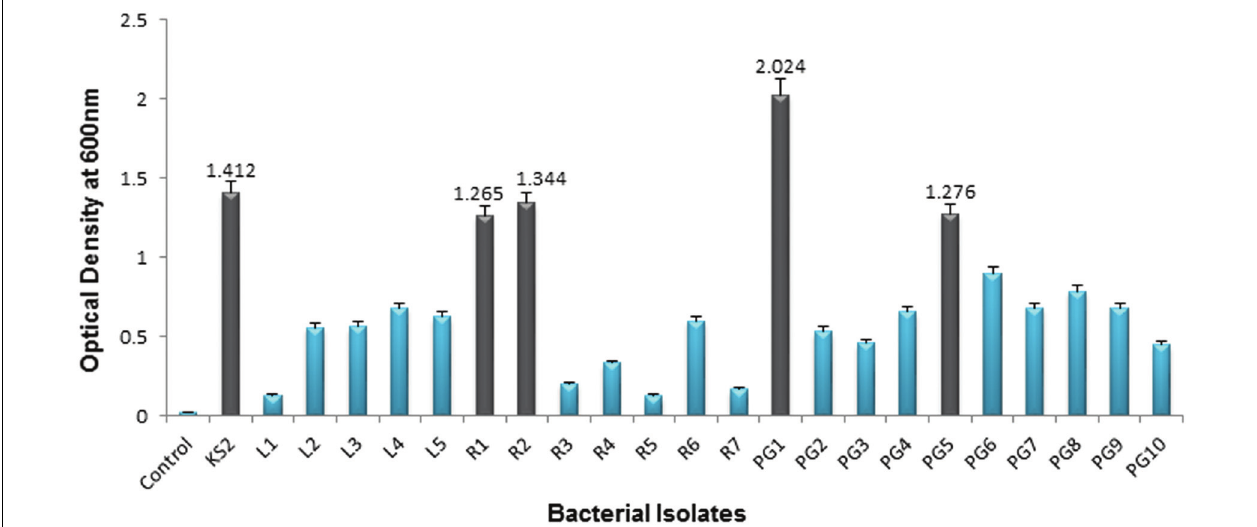
FIGURE 3 | Growth (OD 600 ) of 23 hydrocarbon contaminated soil bacterial isolates on 7th day after incubation in mineral salt media supplemented with 2% (v/v) crude oil. Error bars represent ± standard deviation ( ± SD).